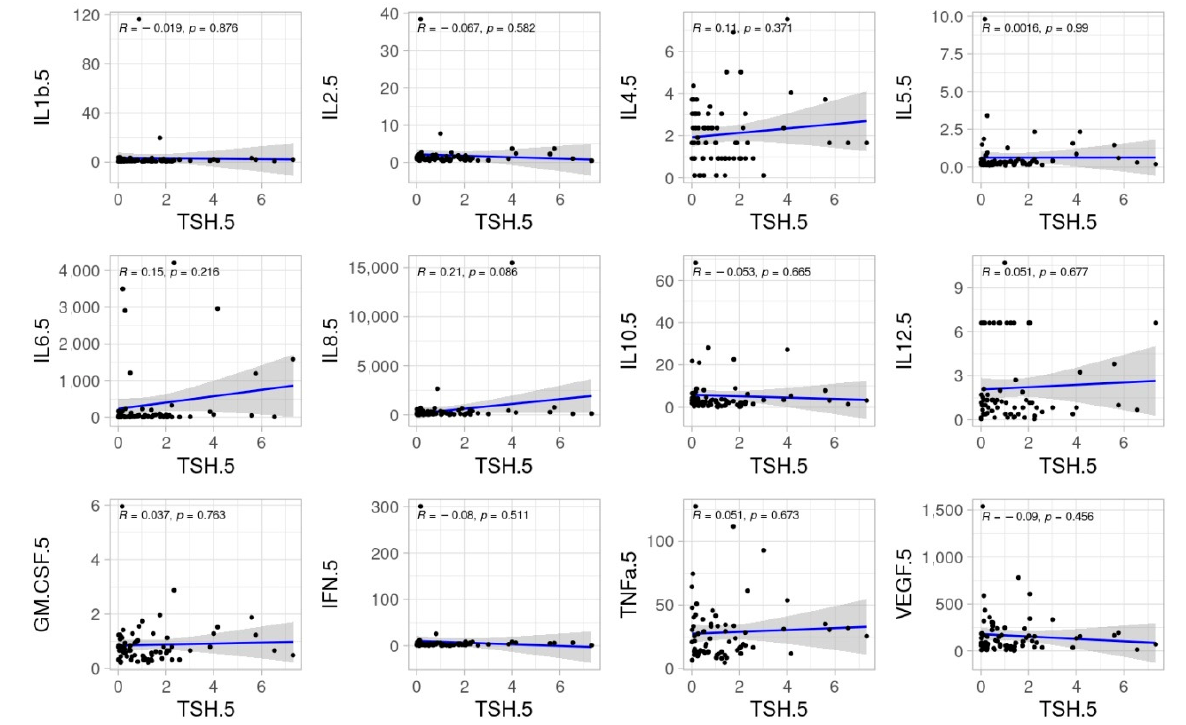
Figure 2. Scatter dots of correlations between TSH and cytokines at day 5.